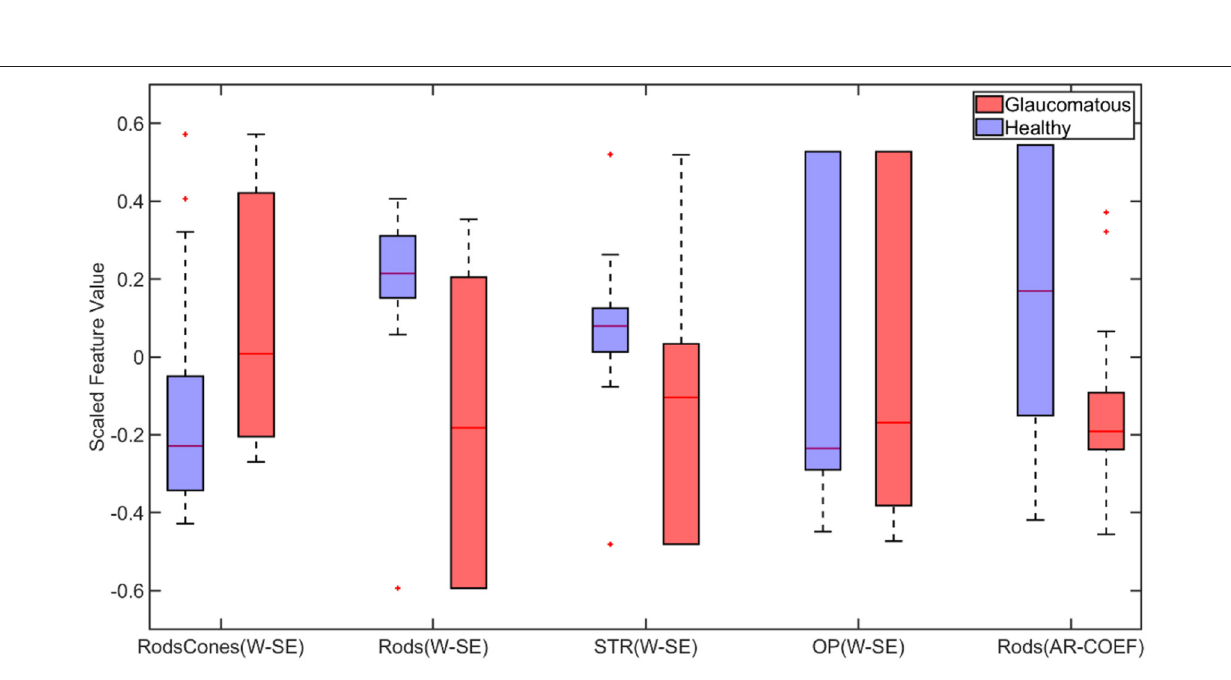
Frontiers in Neuroscience | www.frontiersin.org